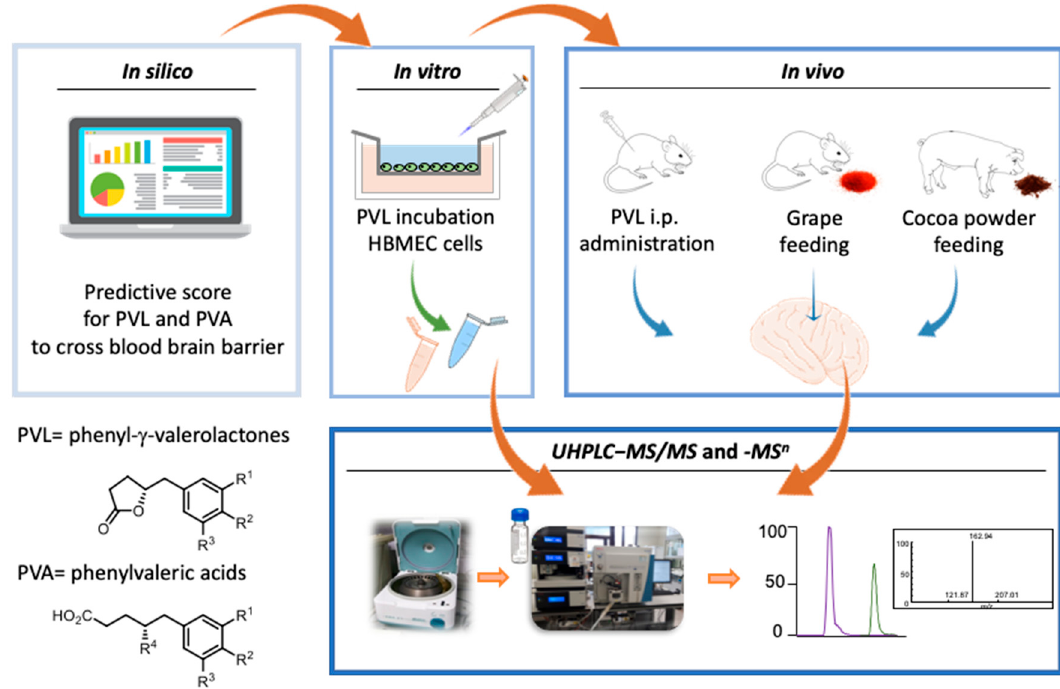
Figure 1. Graphical representation of the in silico, in vitro and in vivo studies conducted in order to investigate the presence of specific flavan-3-ol colonic metabolites into the brain.